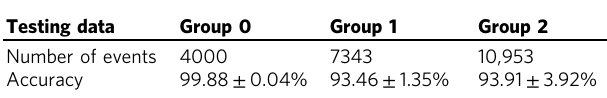
Table 3 Testing